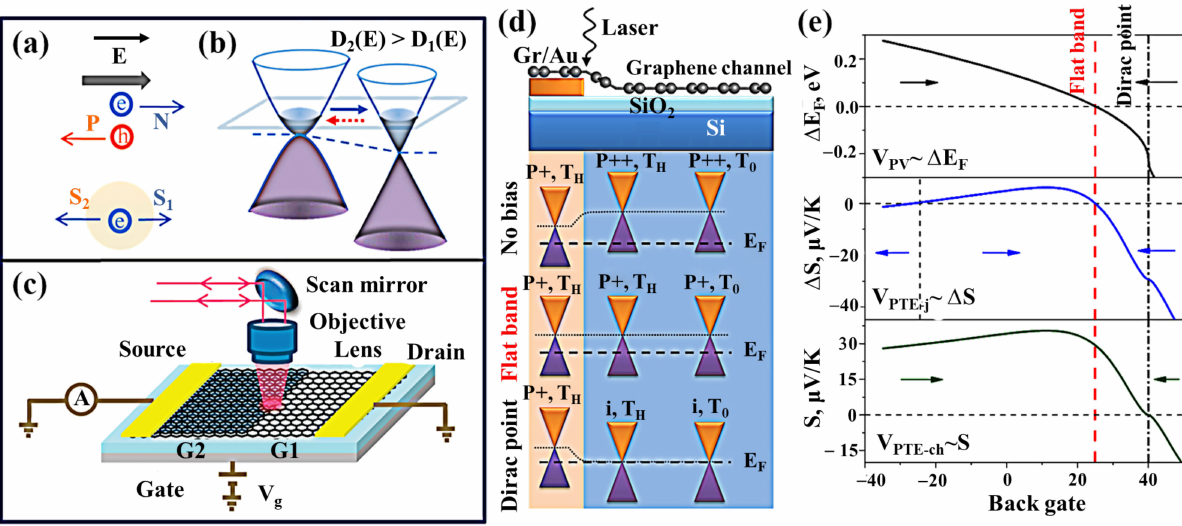
Figure 4. Photothermoelectric Effect. ( a ) In the top panel, the built-in electric field picture for photocurrent generation at a p–n junction. The direction of the field E is defined along the direction of electron movement. In the bottom panel, hot carrier diffusions at a material interface with different S1 and S2. ( b ) Aligned Fermi level of the bilayer ( left ) and single layer ( right ) graphene. D(E) is the density of states. The blue and red dashed arrows represent the electron flow direction induced by the built-in electric field and by the thermoelectric effect, respectively. ( c ) Schematics of the experimental setup and device geometry. ( d ) Schematic of a graphene/Au interface and associated band diagrams for various gating conditions. ( e ) Calculated gate voltage dependence of Fermi level difference ( top ) and Seebeck coefficient difference ( middle ) between the Gr/Au and Gr/SiO 2 areas and gate voltage dependence of Seebeck coefficient for the graphene channel ( bottom ). ( a – c ) reproduced with permission from [48]. Copyright American Chemical Society, 2009. ( d , e ) reproduced with permission from [40]. Copyright Nature Publishing Group,